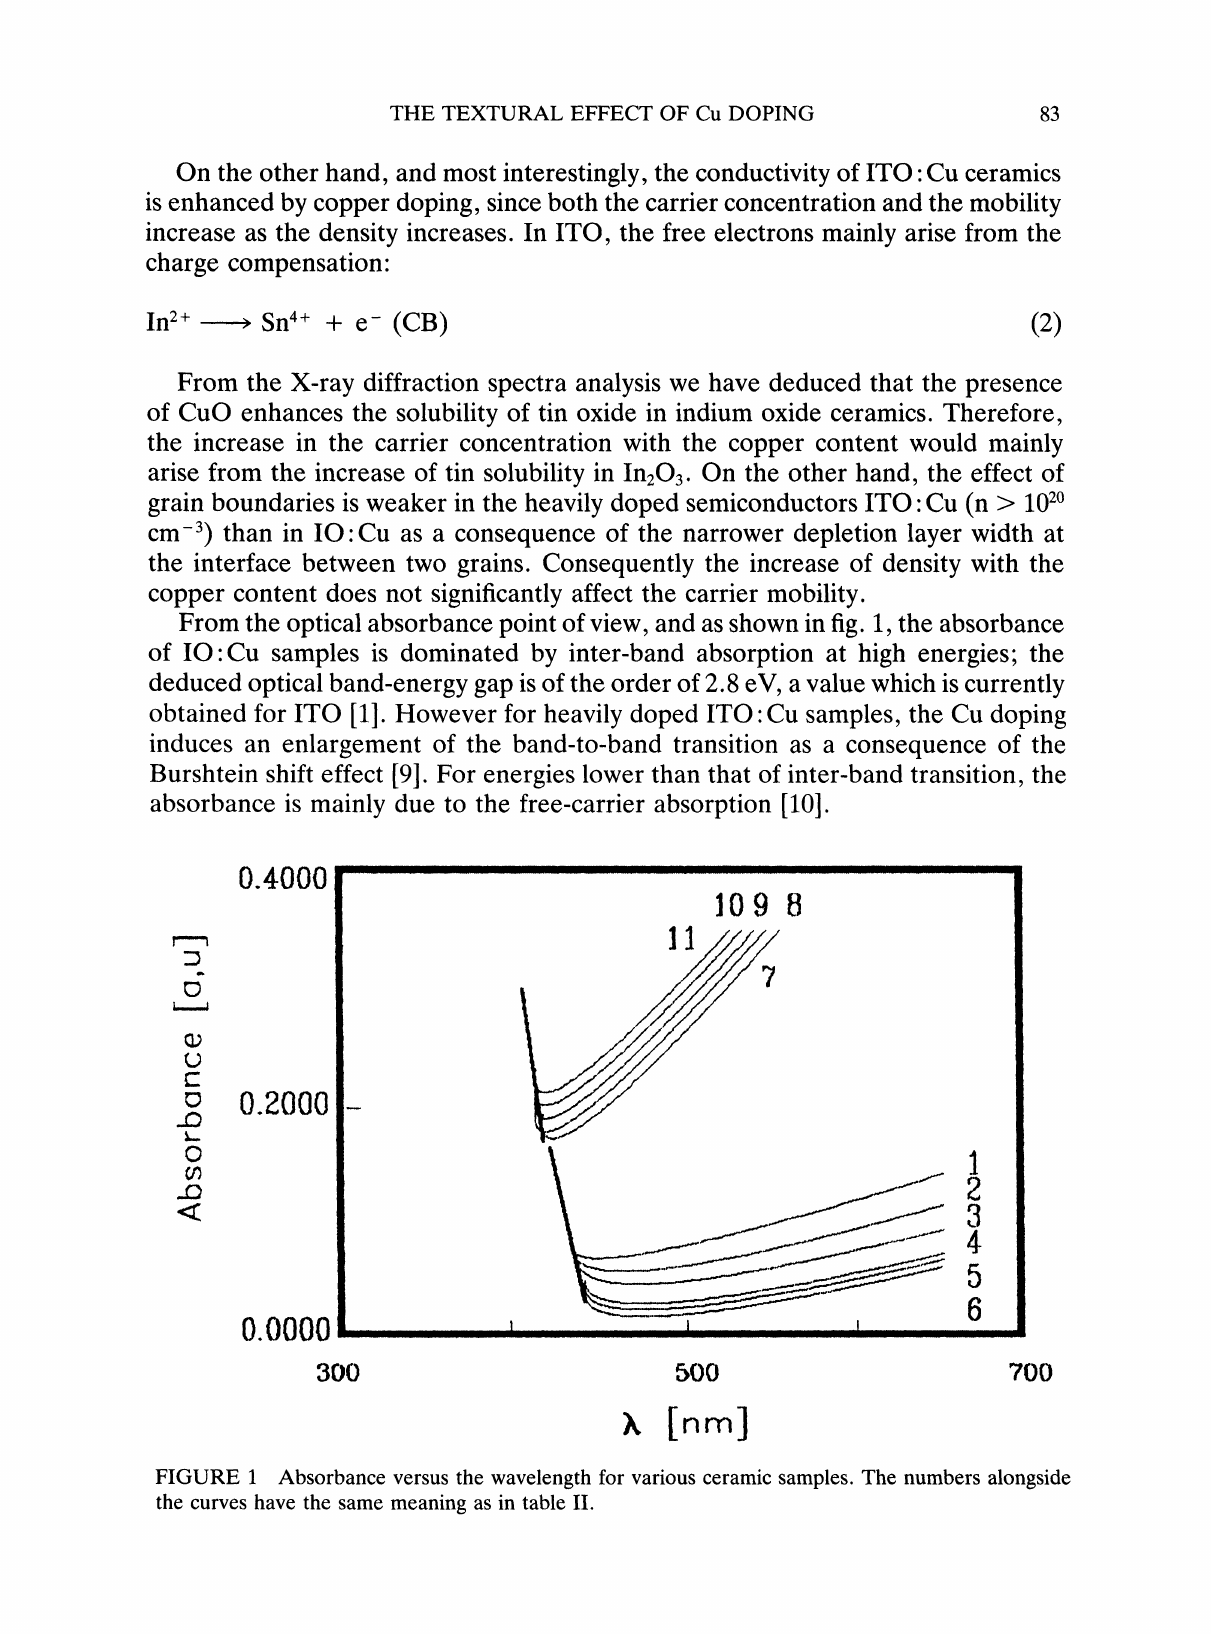
Absorbance versus the wavelength for various ceramic samples. The numbers alongside the curves have the same meaning as in table